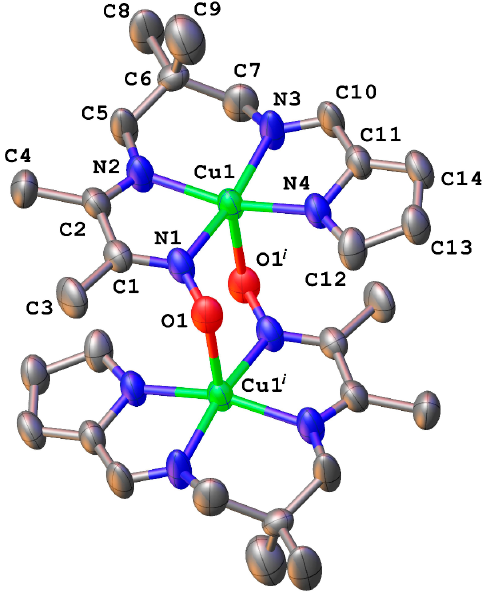
Figure 2. X-ray molecular structure of the dinuclear entity in the crystal structure 2 with atom labeling scheme and thermal ellipsoids at 40% probability level. H-atoms are omitted for clarity. Selected bond lengths (Å) and angles (°). Cu–N1 1.971(2), Cu–N2 1.993(2), Cu–N3 1.983(2), Cu–N4 1.961(2), Cu–O1